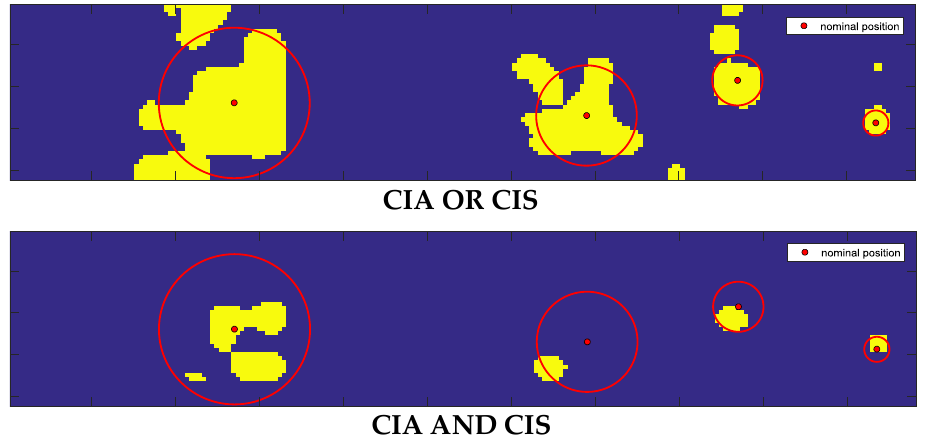
Figure 6. OR-logic map (Top) and AND-logic map (Bottom) from CIA and CIS data shown in Figure 5.